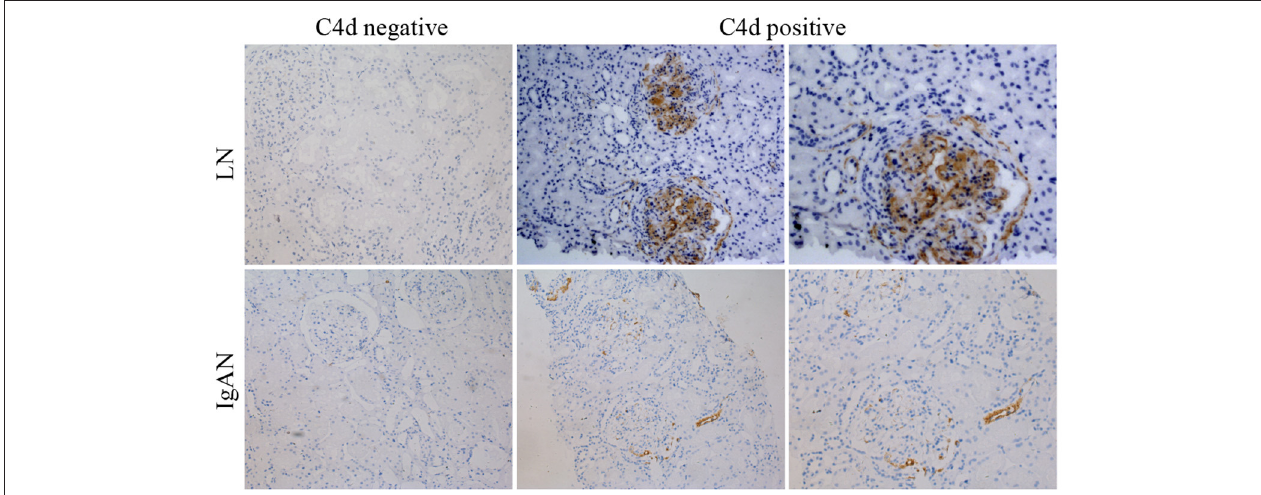
FIGURE 2 | Representative immunohistochemical images showing negative or positive C4d deposition in renal tissue of LN and IgAN patients. The top panels were images for LN patients with negative (left panel) or positive (central and right panel) C4d deposition. The bottom panels were images for IgAN patients with negative (left panel) or positive (central and right panel) C4d deposition. × 200 (left and central panels). × 400 (right panels). LN, lupus nephritis; IgAN, IgA nephropathy.